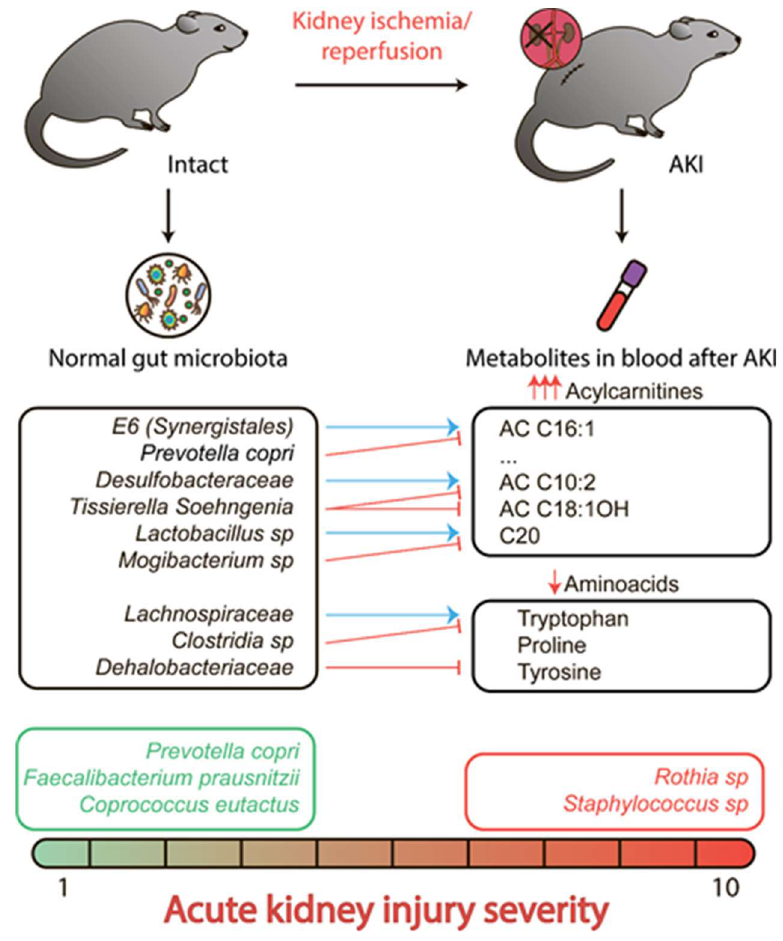
Figure 4. Elevated levels of acylcarnitines and drop of three amino acids concentrations in serum after renal ischemia/reperfusion and its associations with some bacterial clades (blue arrows indicate positive correlation, and red arrows indicate negative correlation). The analysis of bacterial balances revealed that Prevotella copri, Faecalibacterium prausnitzii , and Coprococcus eutactus prevalence was associated with low creatinine and urea levels, whereas Rothia and Staphylococcus positively correlated with severe acute kidney injury.